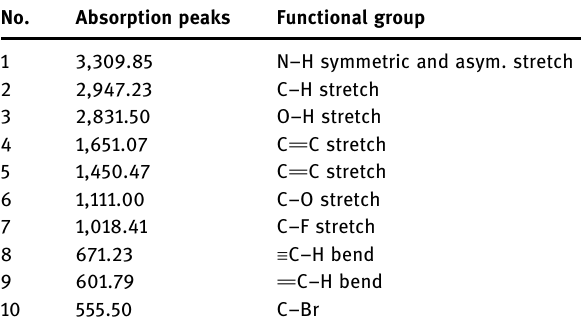
Table 4: FT - IR characterization of the plant composite No. Absorption peaks